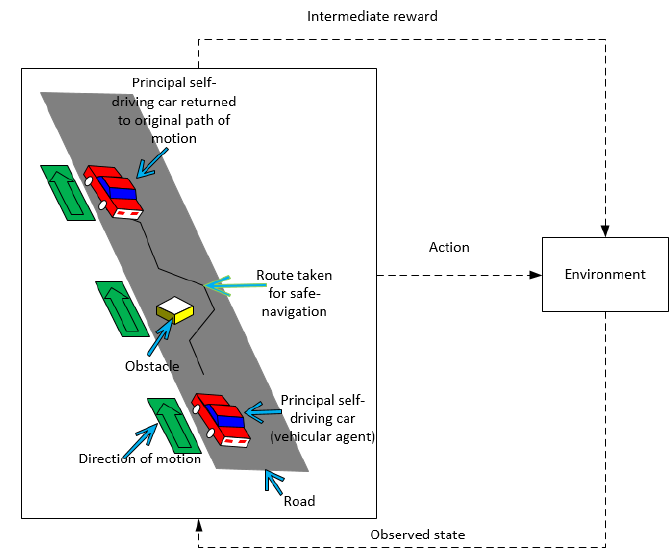
Figure 5. Deep reinforcement learning (DRL) for self-driving